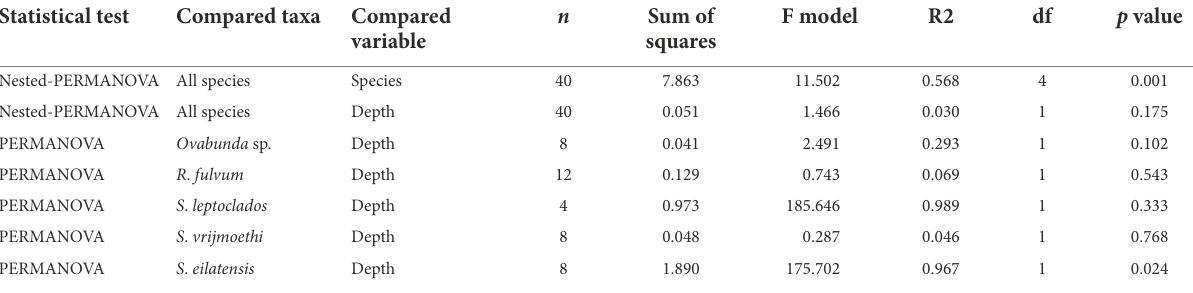
TABLE 2 Results of permutational multivariate analysis of variance of octocoral species harboring Cladocopium ITS2 types in both shallow and MCE environments. Statistical test